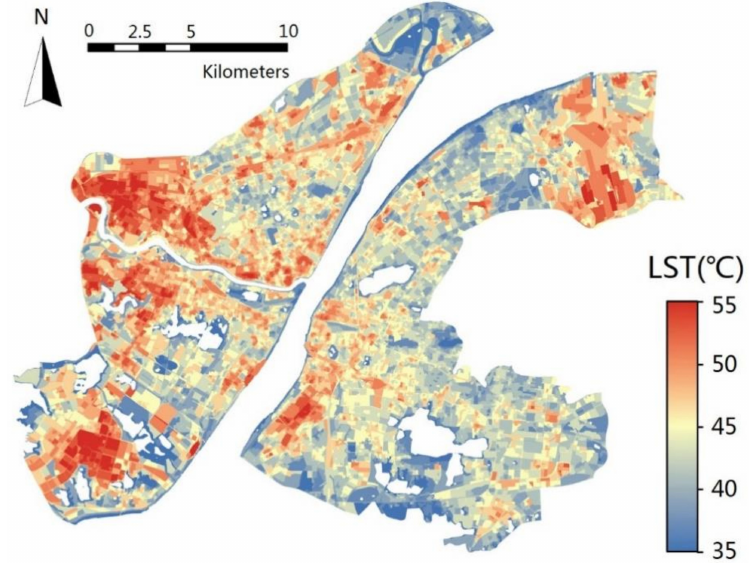
Figure 4. Average land surface temperature (LST) result in UFZs in